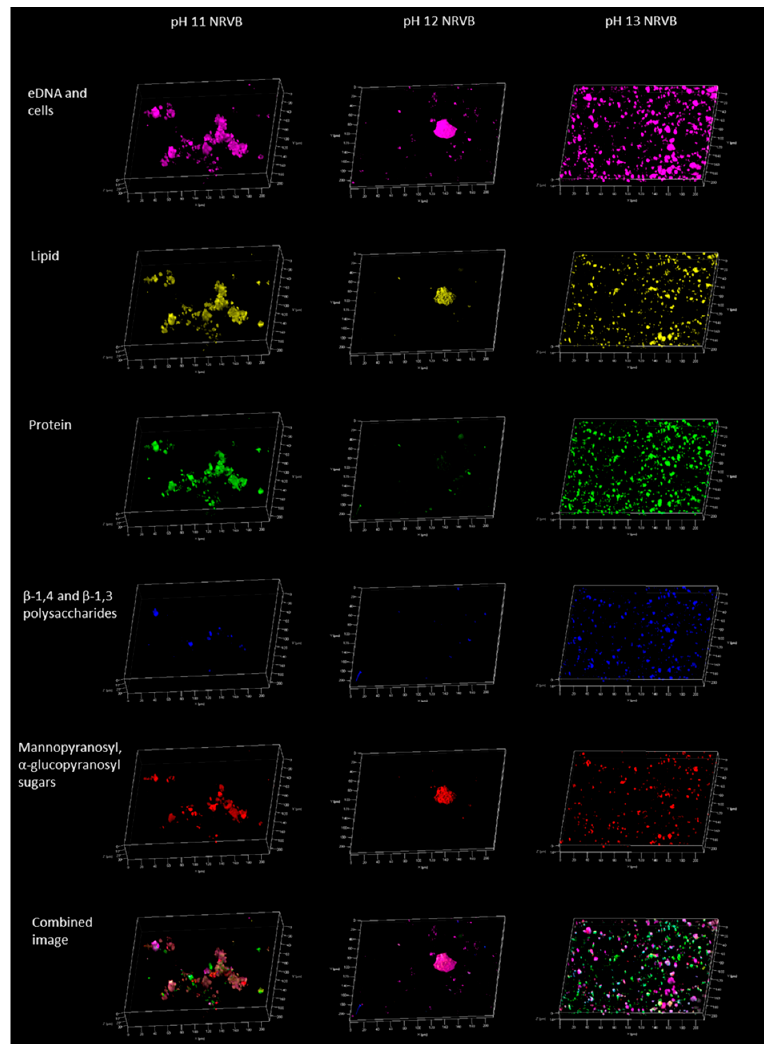
Figure 3. Five colour CLSM imaging of biofilm components on NRVB. At influent pH values of pH 11 and 12, biofilms formed within crevices with a reduced colonisation at pH 12. At pH 13, no obvious biofilm could be observed, however floc organic components were evenly spread across the NRVB